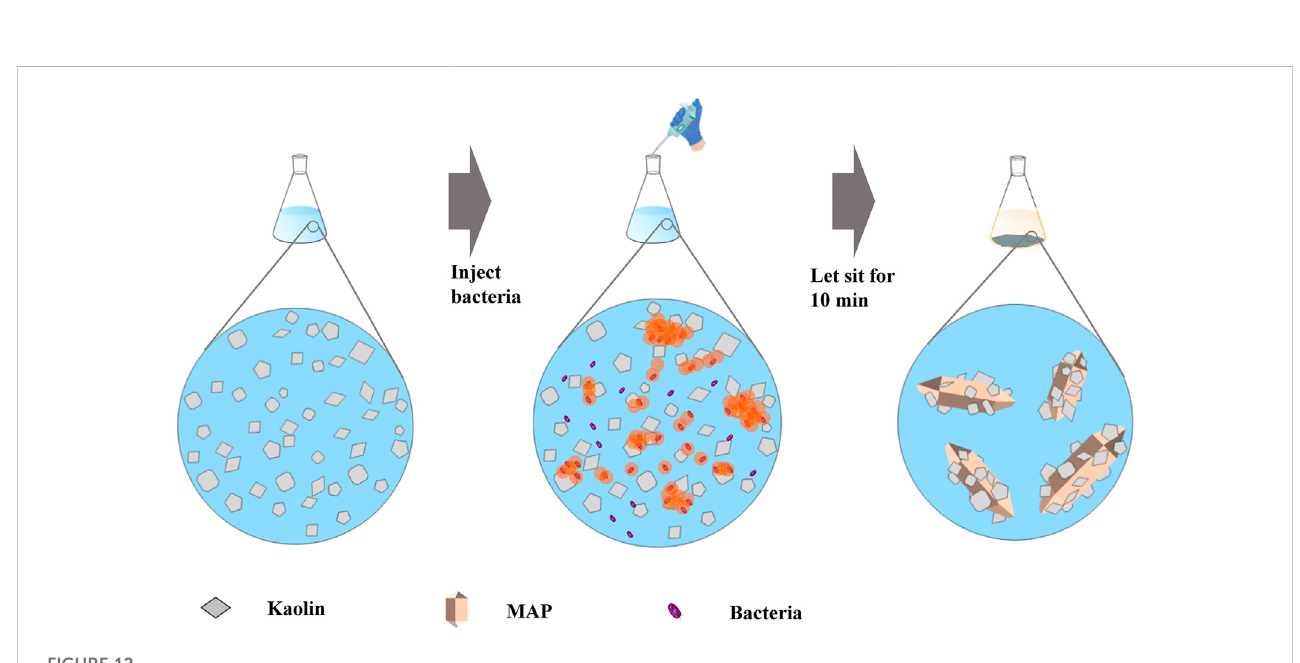
FIGURE 12 Mechanism of MISP for treating